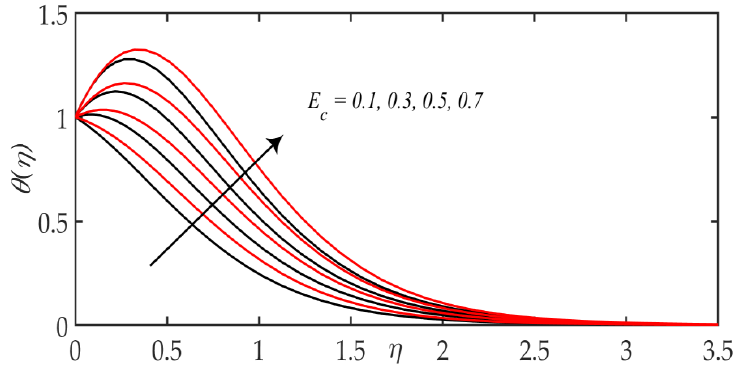
Figure 7. Variation of 𝑁 𝑏 and 𝐸 𝑐 on temperature profile. Black line: 𝑁 𝑏 = 0.2 , Red line: 𝑁 𝑏 = 0.5.